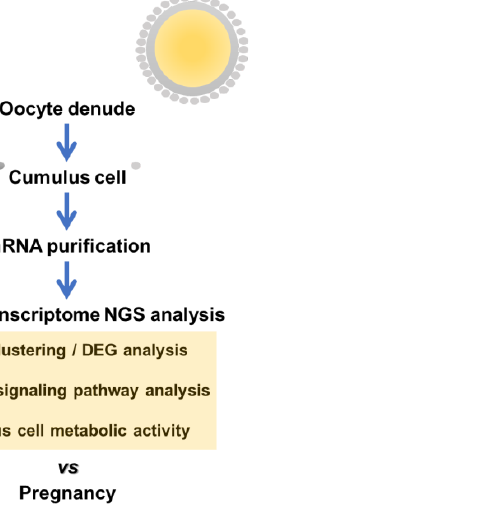
Scheme 1. Design of sample groups for whole-transcriptome analysis of CCs. Table 1. Patients’ characteristics and oocyte profiling of women in the young and old groups, with or without pregnancy. BL: blastocyst, CL: cleavage stage embryo. Significant differences are indi- cated by asterisks (* p < 0.05) .